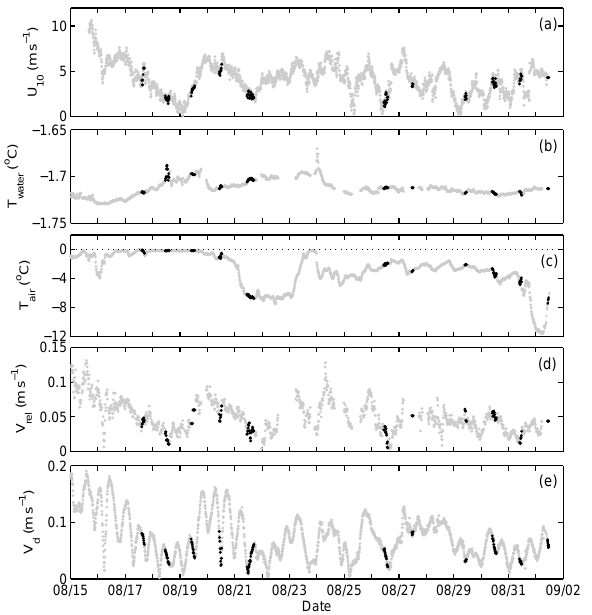
Fig. 6. Time series of mean conditions during ASCOS: (a) wind speed (U10), (b) water temperature ( T water ), (c) air temperature ( T air ), (d) current speed relative to ice at 2m below underside of ice (e) the drift speed of the ice floe. The black points indicate the periods during which the bubble spectra were obtained.